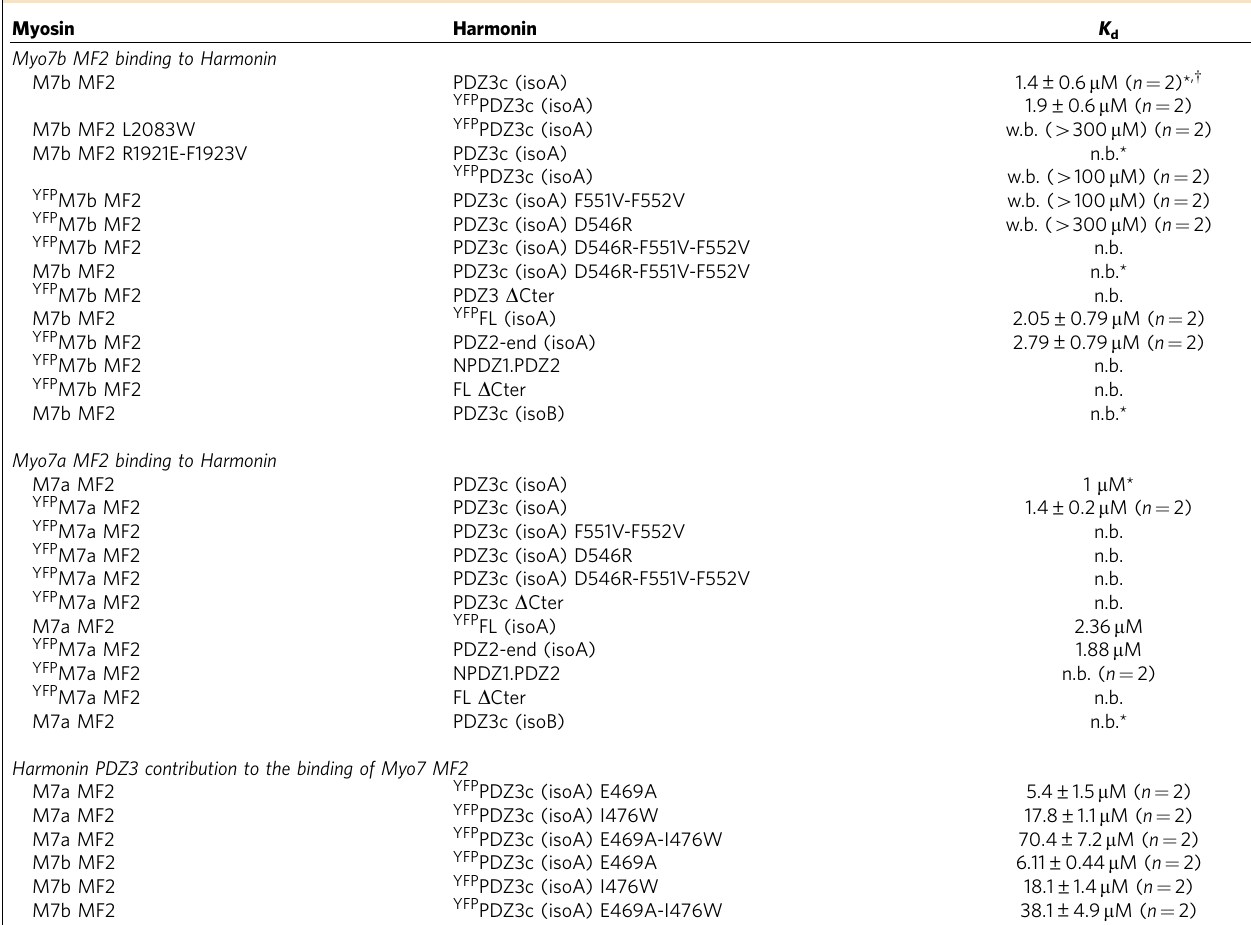
Table 3 | Structural basis for harmonin PDZ3c recognition by Myo7b MF2. Myosin